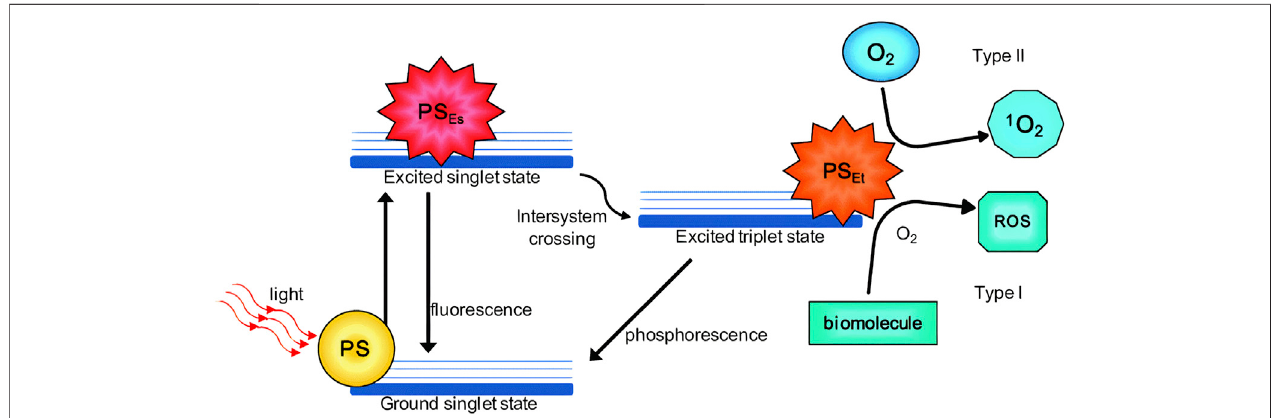
FIGURE3| TypeIandTypeIIreactionsinPDT(photodynamictherapy).SchematicJablonski ’ sdiagramshowingPDT ’ smechanismofaction.PS:photosensitizer; PSEs: PS excited singlet state; PS Et , PS excited triplet state; ROS, reactive oxygen species; 1 O 2 , singlet oxygen. Source (Calixto et al., 2016).